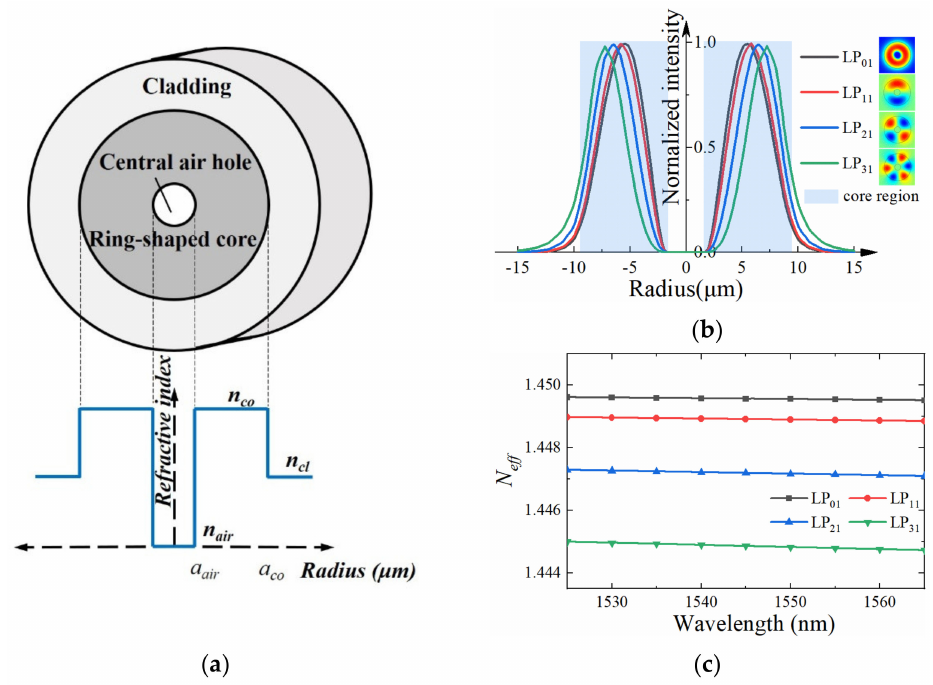
Figure 1. ( a ) Schematic diagram and the refractive index distribution of the AH-FM-EDF; ( b ) Nor- malized intensities and ( c ) effective refractive indices of the guide